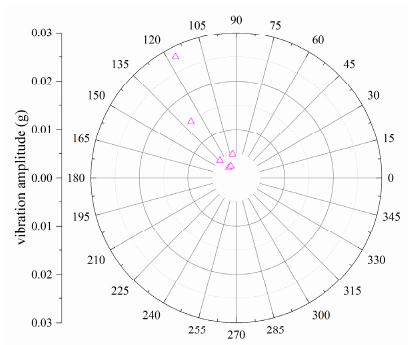
Figure 24. Lateral polar diagram of trailing-edge